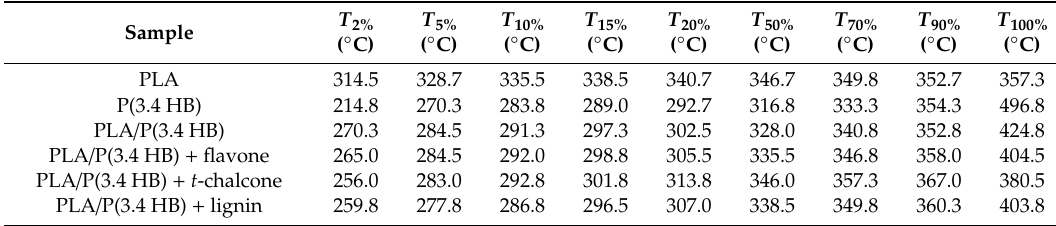
Figure 2. TGA curves of PLA/P(3.4 HB) composites with selected natural antioxidants in comparison to reference PLA, P(3.4 HB) and PLA/P(3.4 HB) samples. Table 3. Temperatures of the tested materials weight loss. T x% is temperature at which the weight loss is x%.